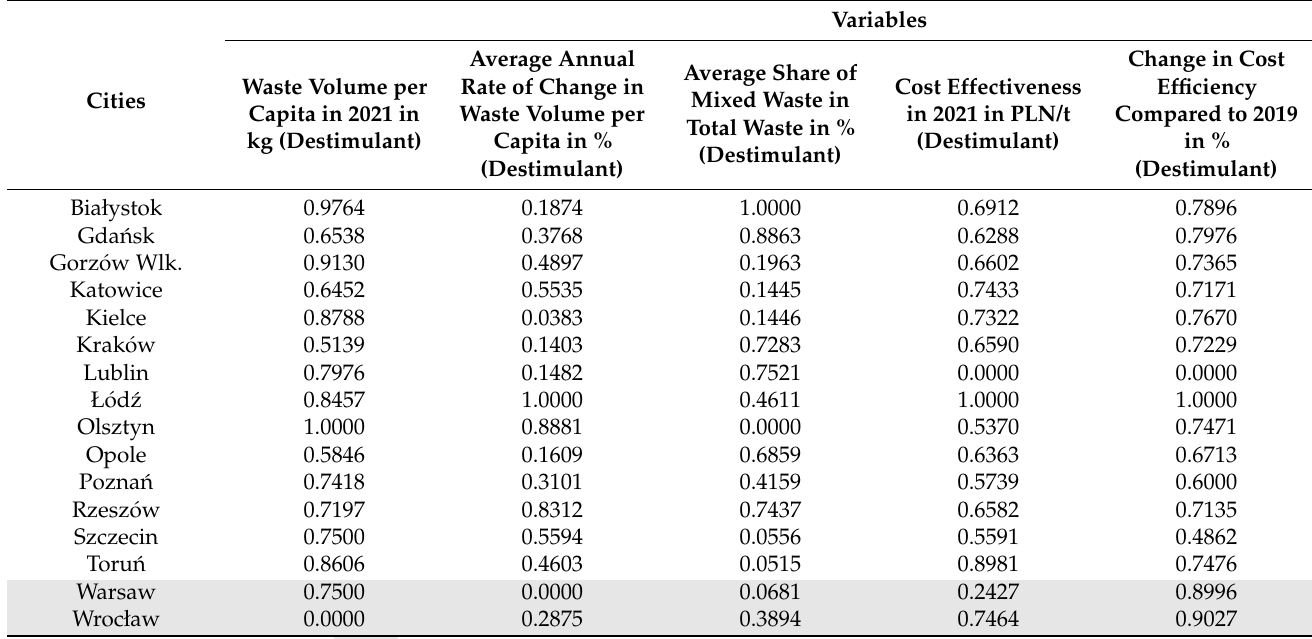
Table 6. The results of multi-criteria analysis for the analyzed cities.